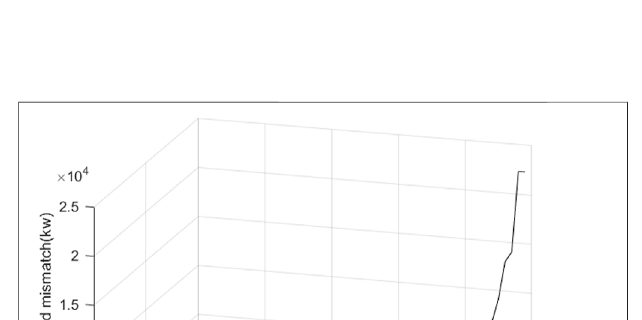
FIGURE 9 | Heat supply-demand mismatch.